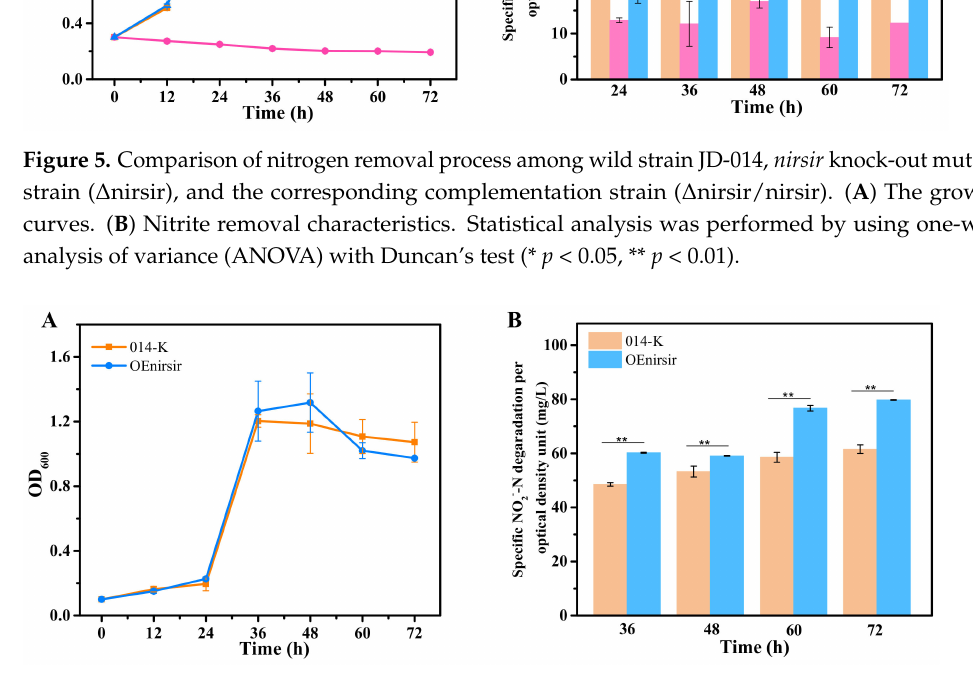
Figure 6. Comparison of nitrogen removal process between control strain (014-K) and nirsir over- expressing mutant strain (OEnirsir). ( A ) The growth curves. ( B ) Nitrite removal characteristics. Statistical analysis was performed by using one-way analysis of variance (ANOVA) with Duncan’s test (** p <